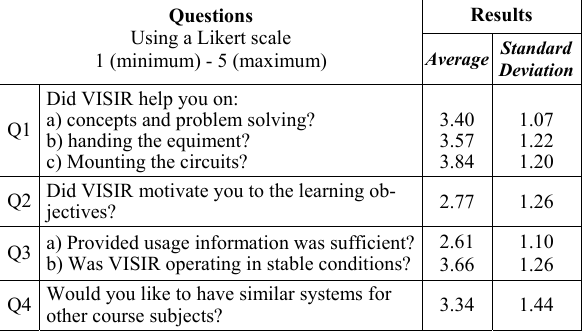
Results Questions